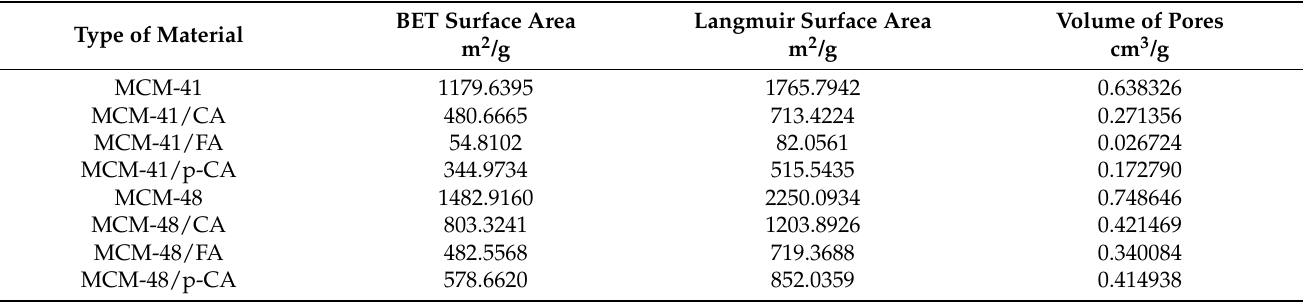
Table 2. BET characteristics of mesoporous